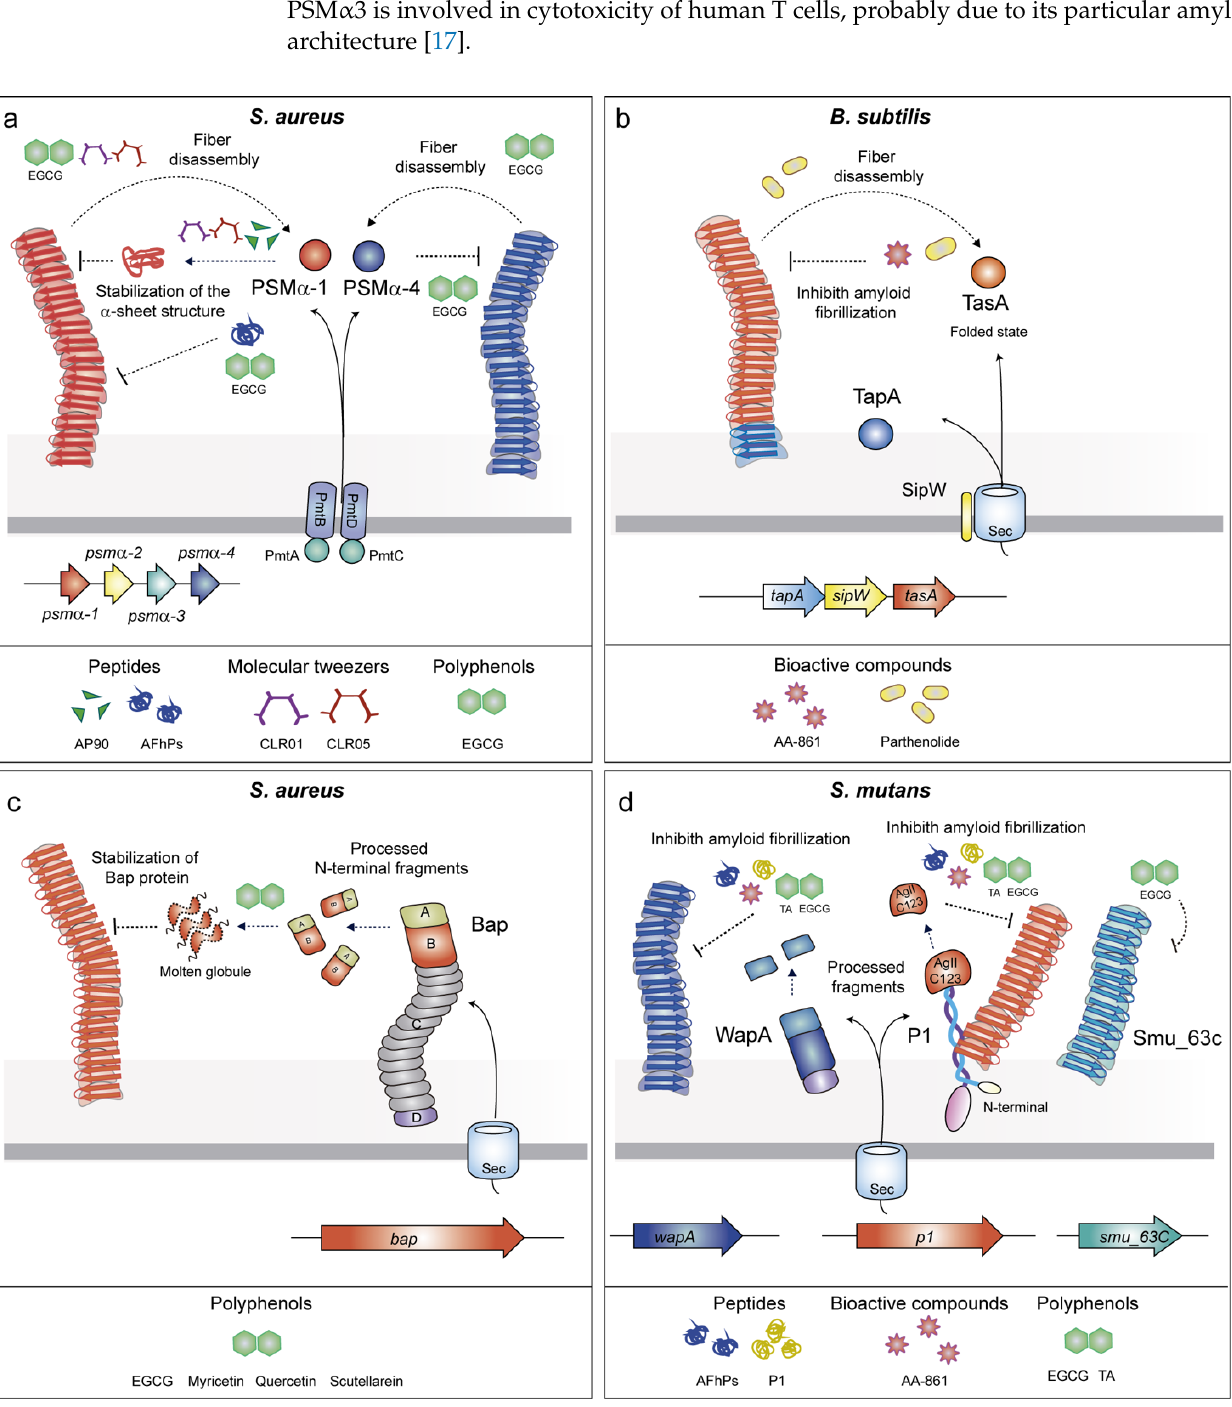
Figure 2. Schematic representation of the genes involved in the assembly of facultative amyloids, the drugs targeting such structures and their mechanism of action. ( a ) Drugs targeting S. aureus PSMs act by several mechanisms that involve the stabilization of PSM α -sheet structure and fiber disassembly. ( b ) B. subtilis TapA polymerization is inhibited by AA-861 and parthenolide. ( c ) The flavonoids quercetin, myricetin, and scutellarein inhibit polymerization of the Bap amyloid aggregates by stabilization of the Bap protein. ( d ) Polymerization of the amyloids S. mutants WapA and AgII/C123 is inhibited by AA-861, Tannic acid (TA), and EGCG and indirectly by the AFhPs and P1 peptides. SMU_63c amyloids are inhibited by EGCG.